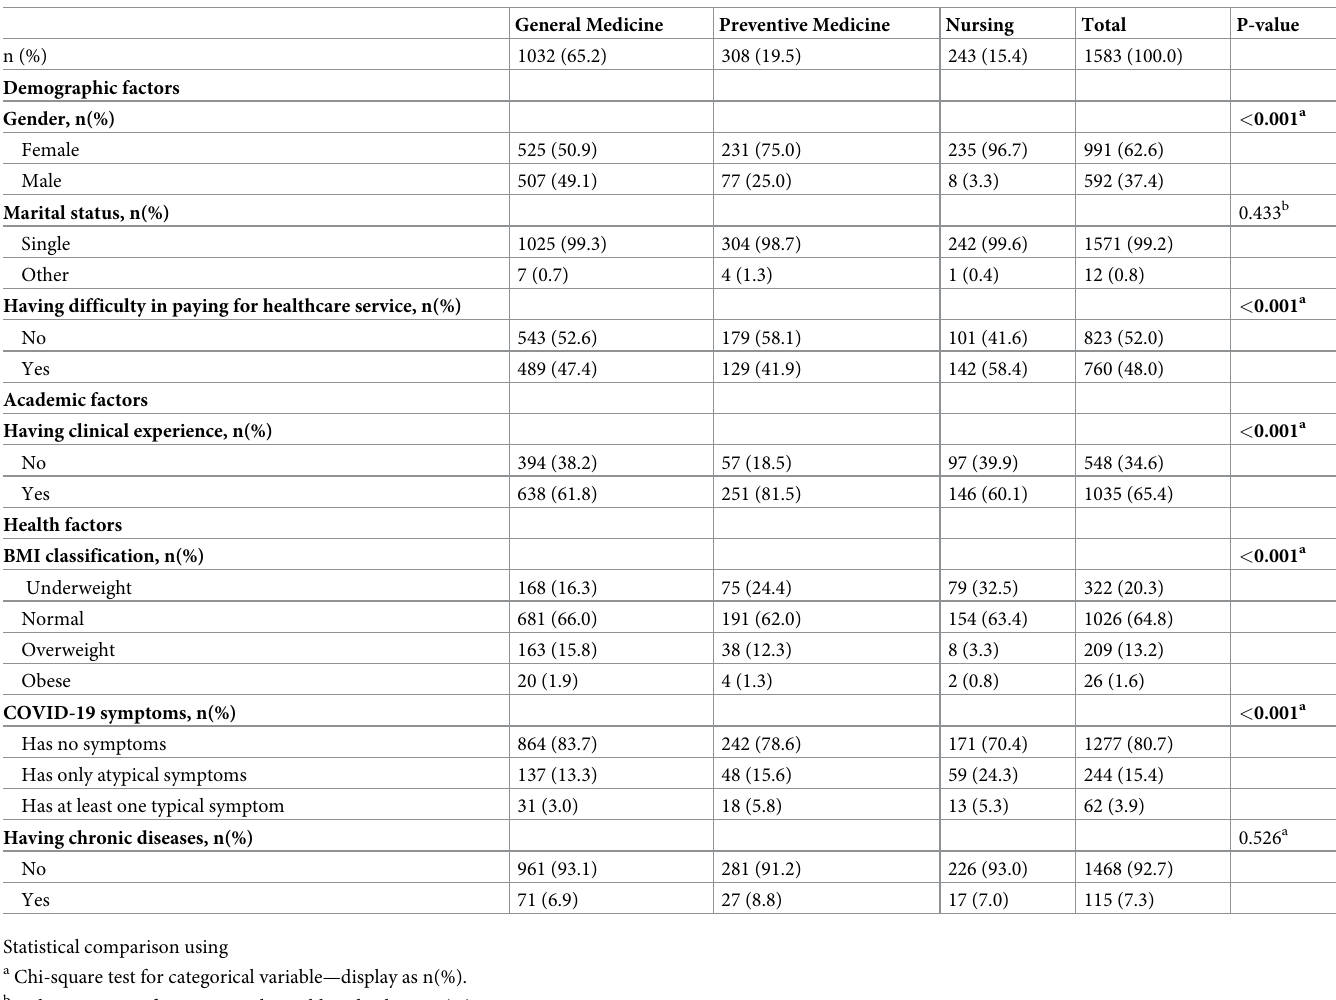
Table 1. Characteristic of